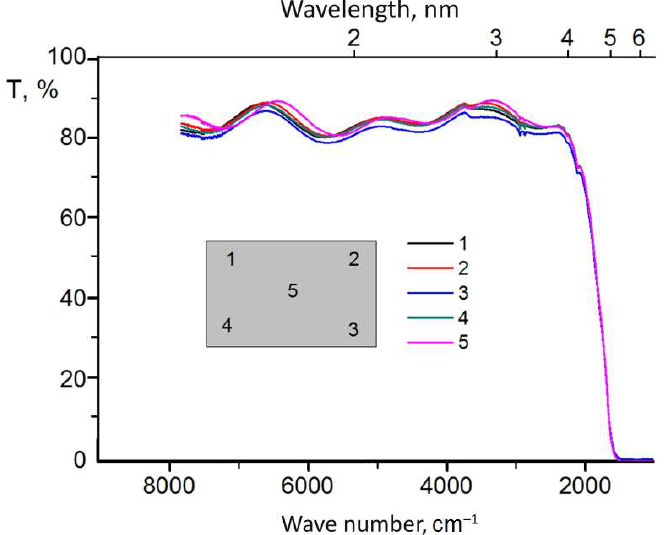
Figure 8. Optical transmittance in the infrared region of the spectrum of samples with interference Si–SiO coating, formed on a sapphire substrate with dimensions of 150 × 80 mm at the investigated 1–5 zones.